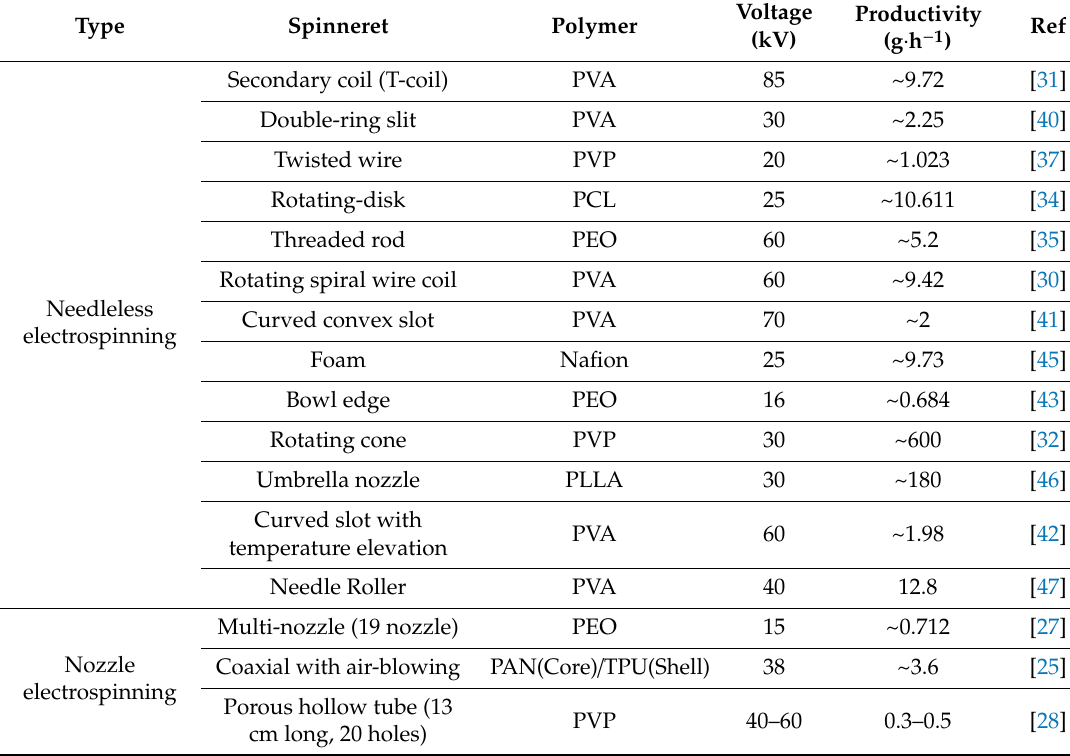
Table 1. Summary of productivity of di ff erent spinning